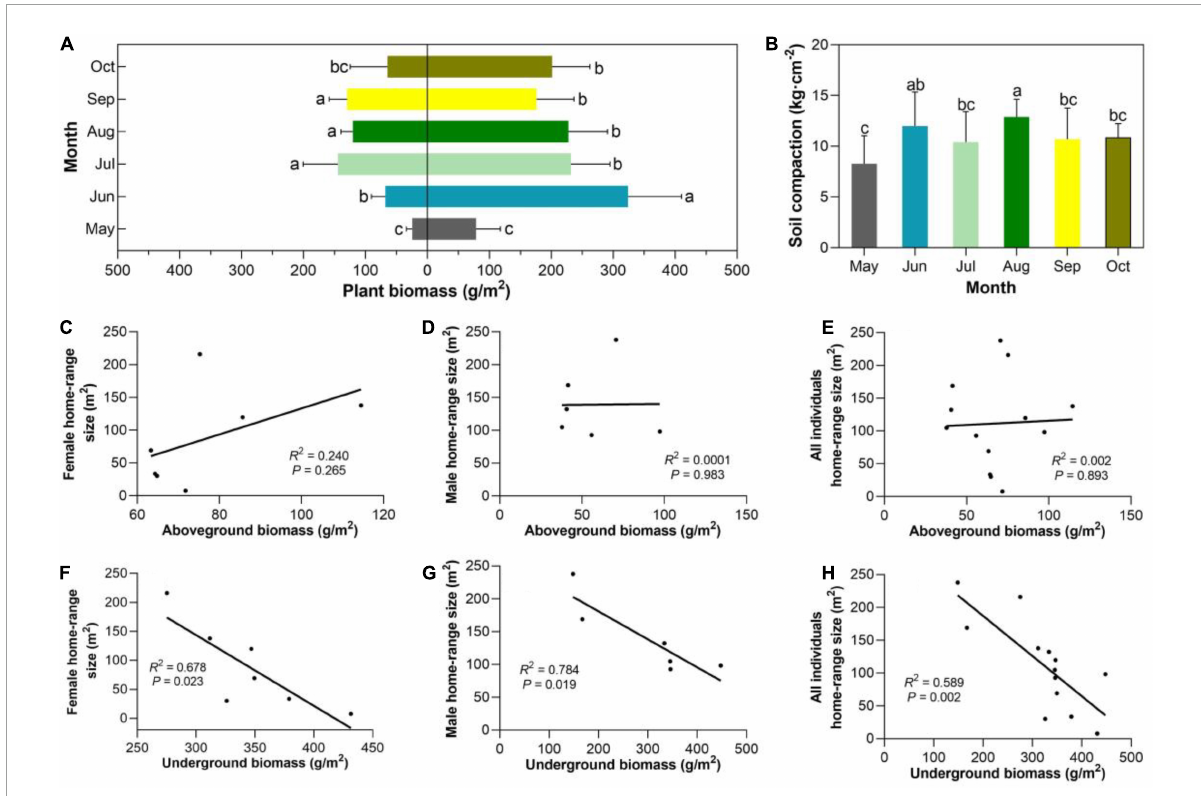
FIGURE5 (A) Aboveground and underground plant biomass. The lowercase letters represent the differences between months. (B) Changes in soil compaction. Relationships between the aboveground (or underground) biomass with the average size of the home range of female (C,F) , male (D,G) , and all individuals (E,H) in June,